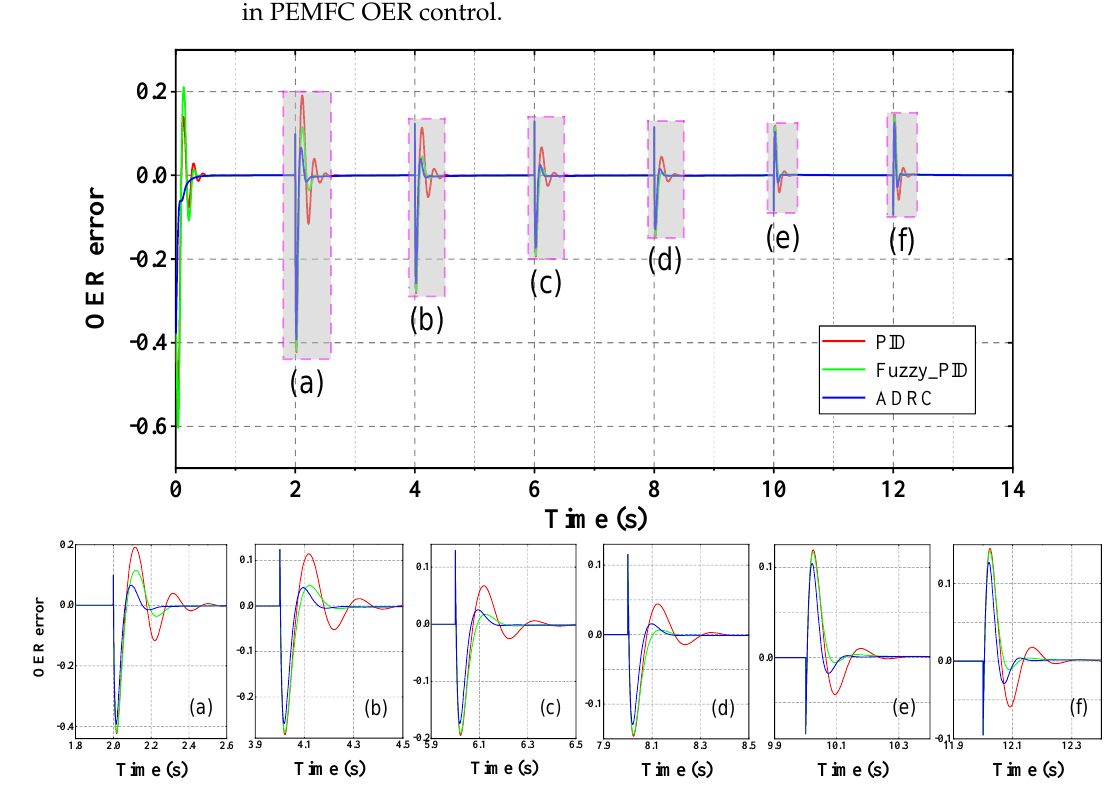
Figure 8. OER tracking errors under different control methods (( a – f ) is the enlarged view of the 2nd, 4th, 6th, 8th, 10th and 12th seconds respectively).